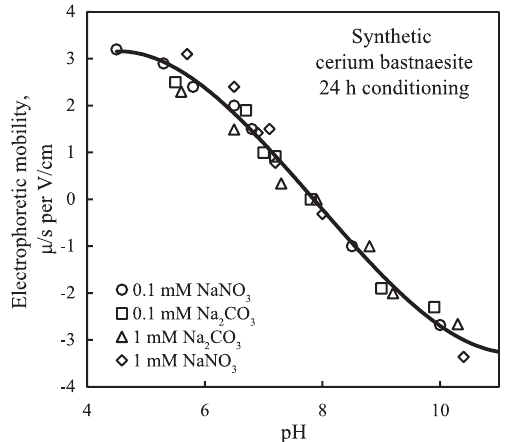
Fig. 2 Electrophoretic mobility of synthetic cerium bastn- aesite as a function of pH in the presence and absence of NaF.